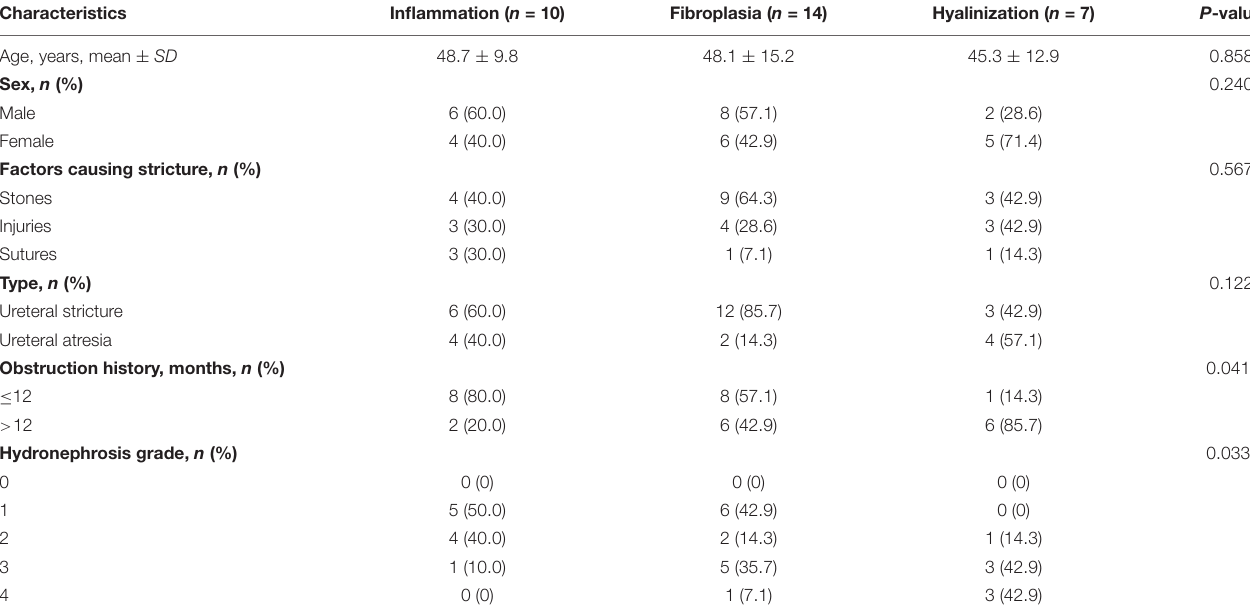
TABLE 2 | Clinical characteristics of